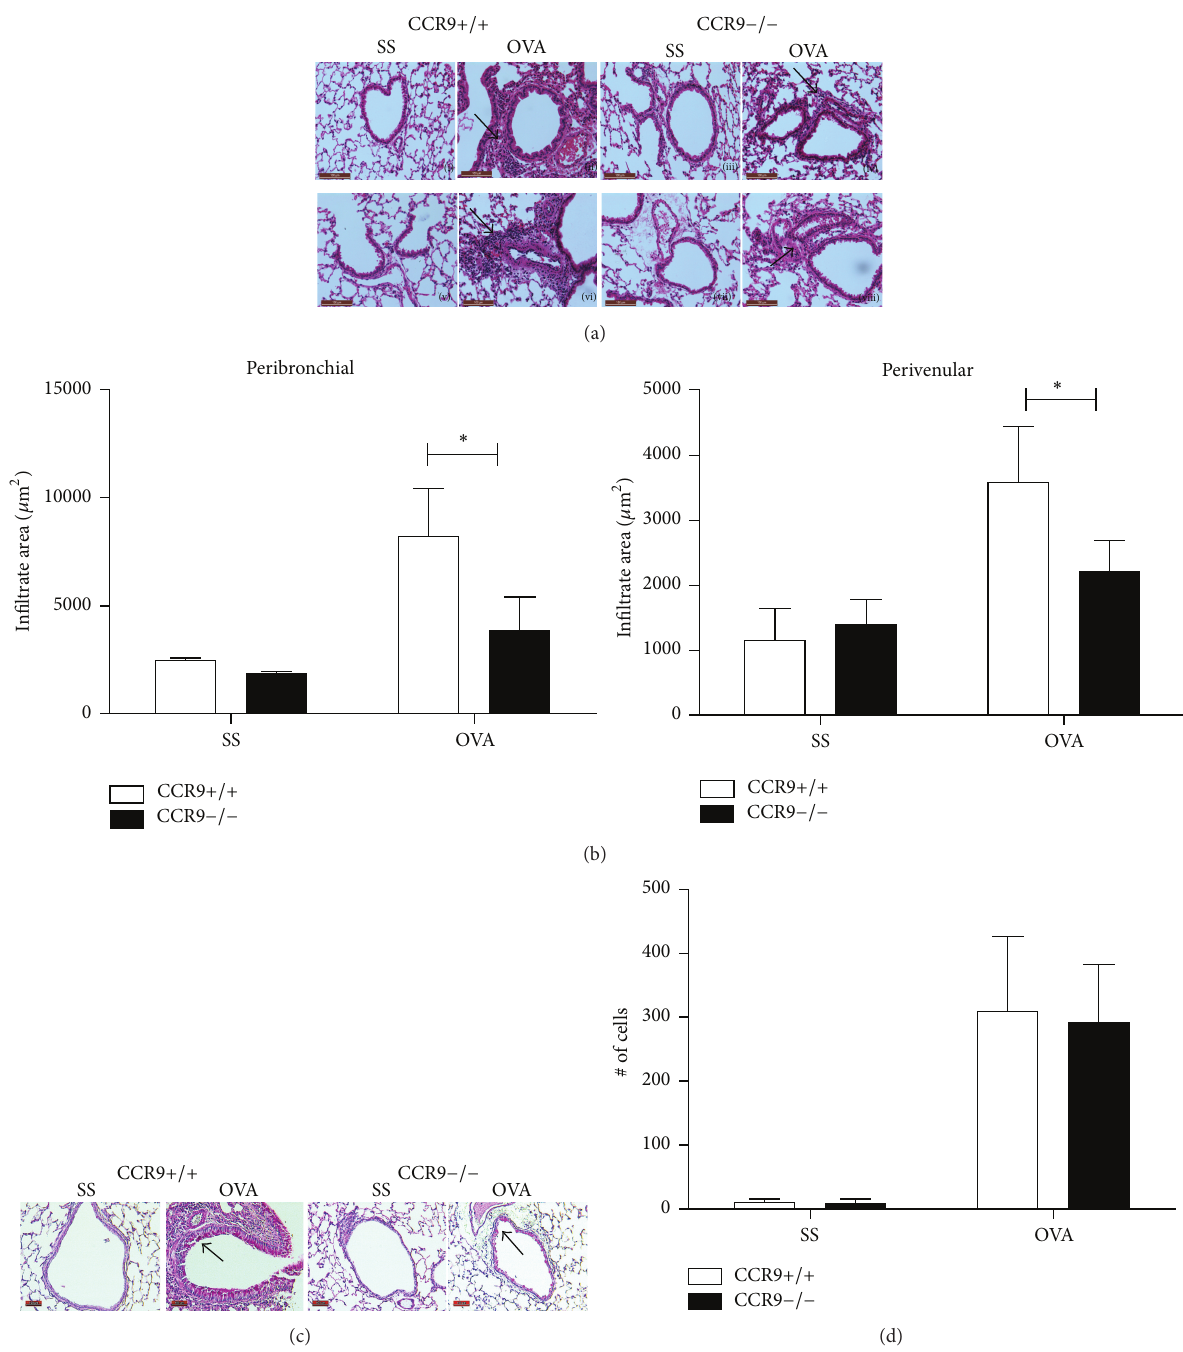
Figure 2: Allergic airway inflammation in the absence of CCR9. Lungs from SS- and OVA-treated mice were fixed and stained with H&E. (a) Representative images from peribronchial (i–iv) and perivenular (v–viii) inflammation. Arrows indicate leukocyte infiltration (magnification